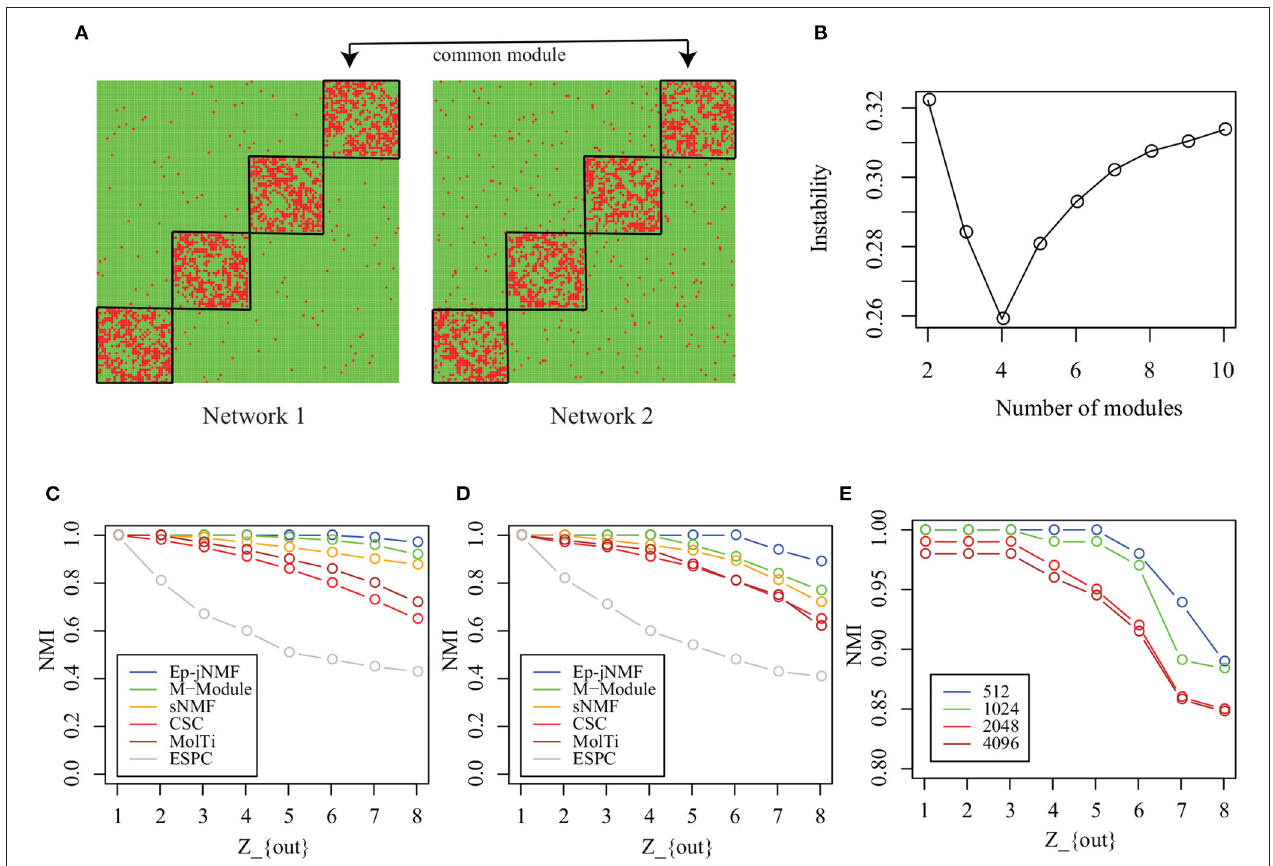
FIGURE 3 | Performance on artificial networks: (A) Heatmap of common modules in Homo-Net ( Z out = 1); (B) selection of the number of modules using instability of matrix factorization with various noise levels; (C) NMIs of algorithms on Homo-Net; (D) NMI of algorithms on Heter-Net; and (E) scalability analysis of Ep-jNMF.